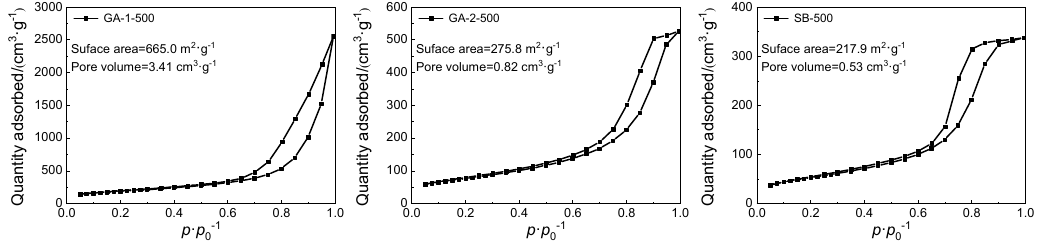
Figure 3. The results of N 2 adsorption / desorption analysis of alumina adsorbents.